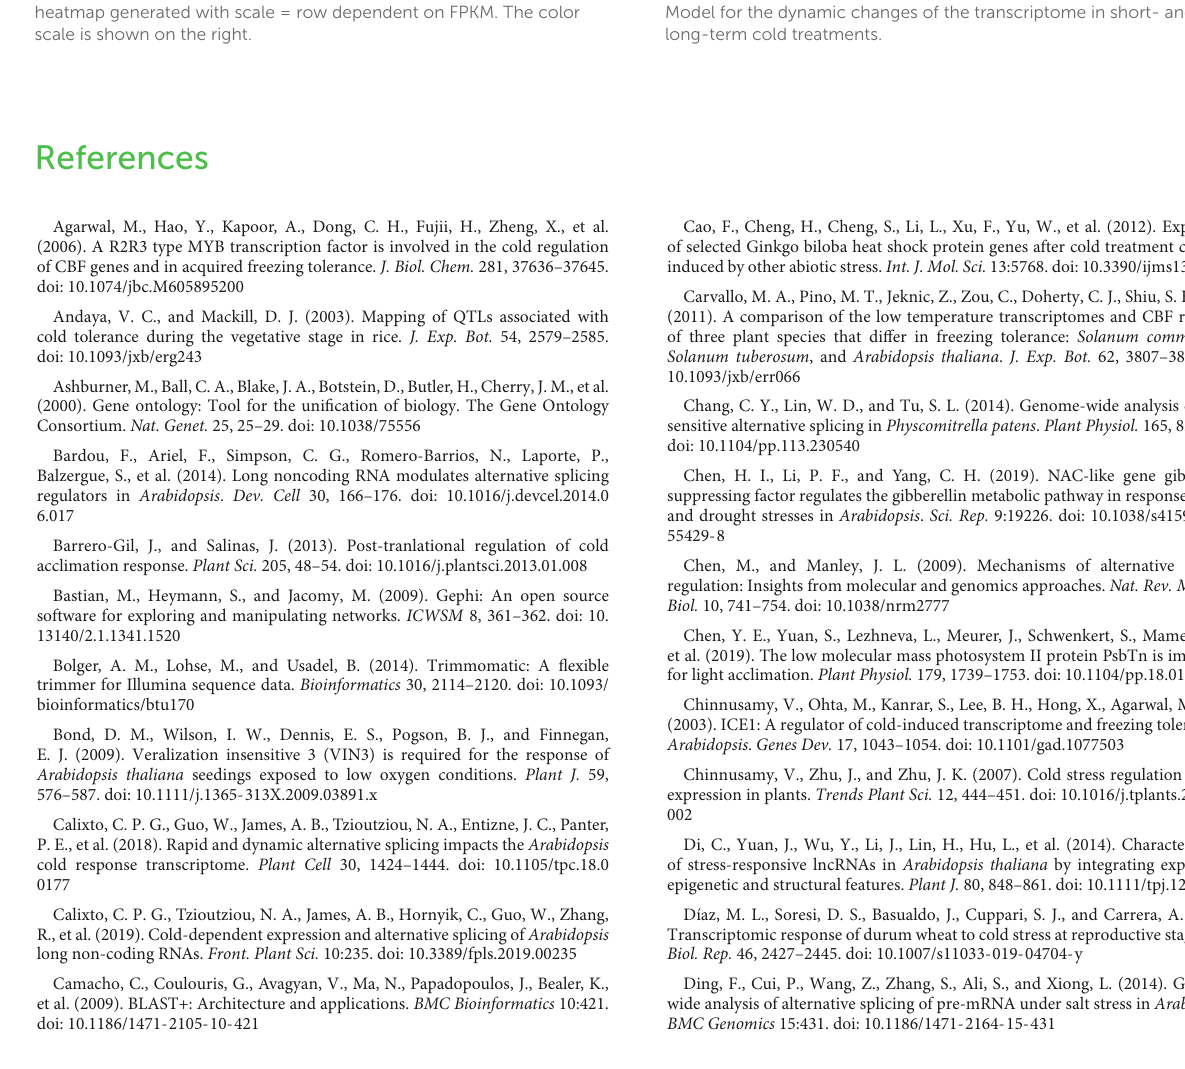
warm colors (yellow, red), and low membership values in cool colors (green, blue).